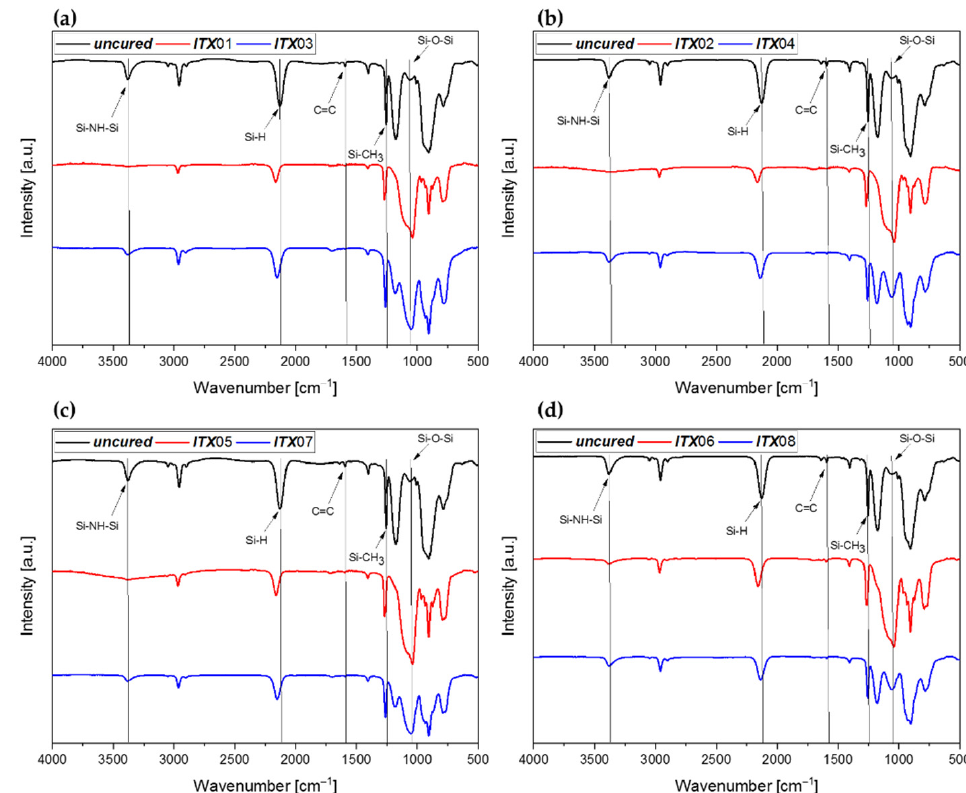
Figure 11. FTIR spectra of the uncured and cured Durazane 1800 sample mixed with DMABP as photoinitiator. The red curves were cured in ambient atmosphere and the blue curves in nitrogen atmosphere. Black curves belong to the uncured sample. ( a ) ITX 01 and ITX 03, ( b ) ITX 02 and ITX 04 cured by the LED source ( λ = 385 nm). ( c ) ITX 05 and ITX 07, ( d ) ITX 06 and ITX 08 cured by the LED source ( λ = 405 nm).